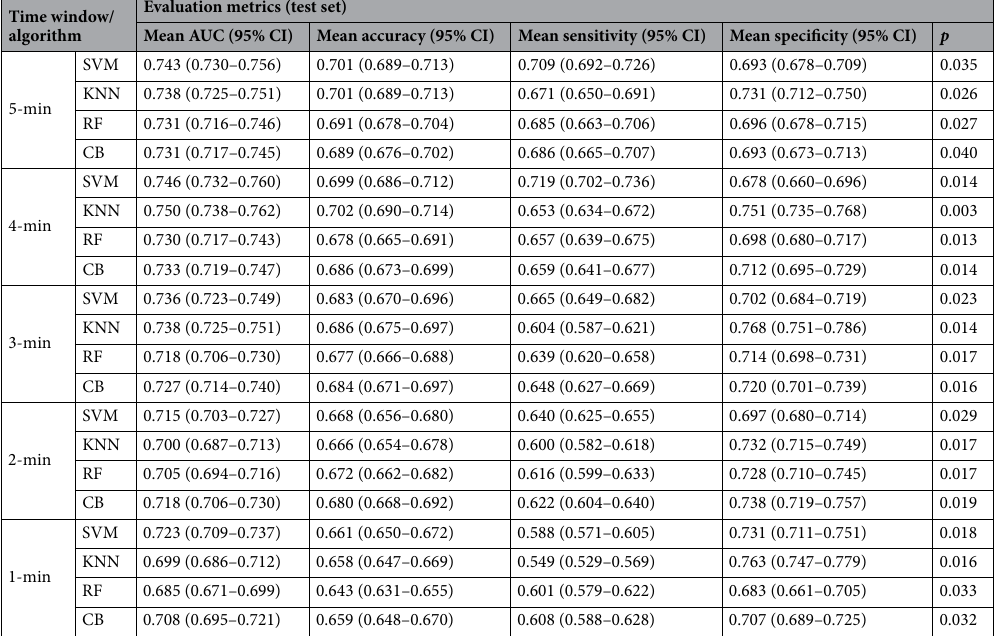
Table 2. Results of the classifiers trained on resting HRV. AUC area under the receiver operating characteristic curve, CB CatBoost classifier, CI confidence interval, KNN k-nearest neighbors, p permutation test p-value, RF random forest, SVM support vector